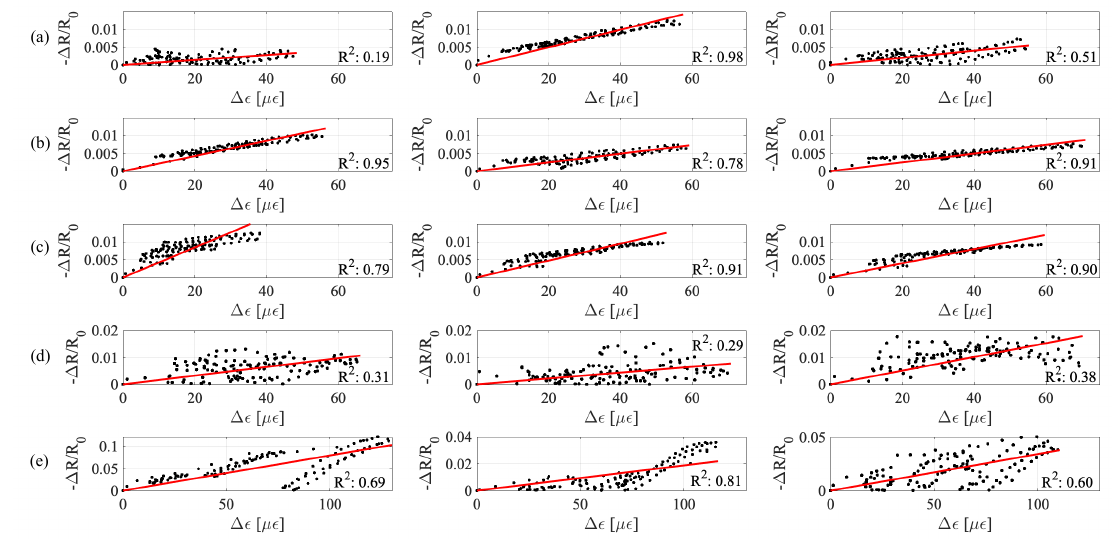
Figure 8. Relative change in resistance versus strain for all samples, along with best linear fit lines: